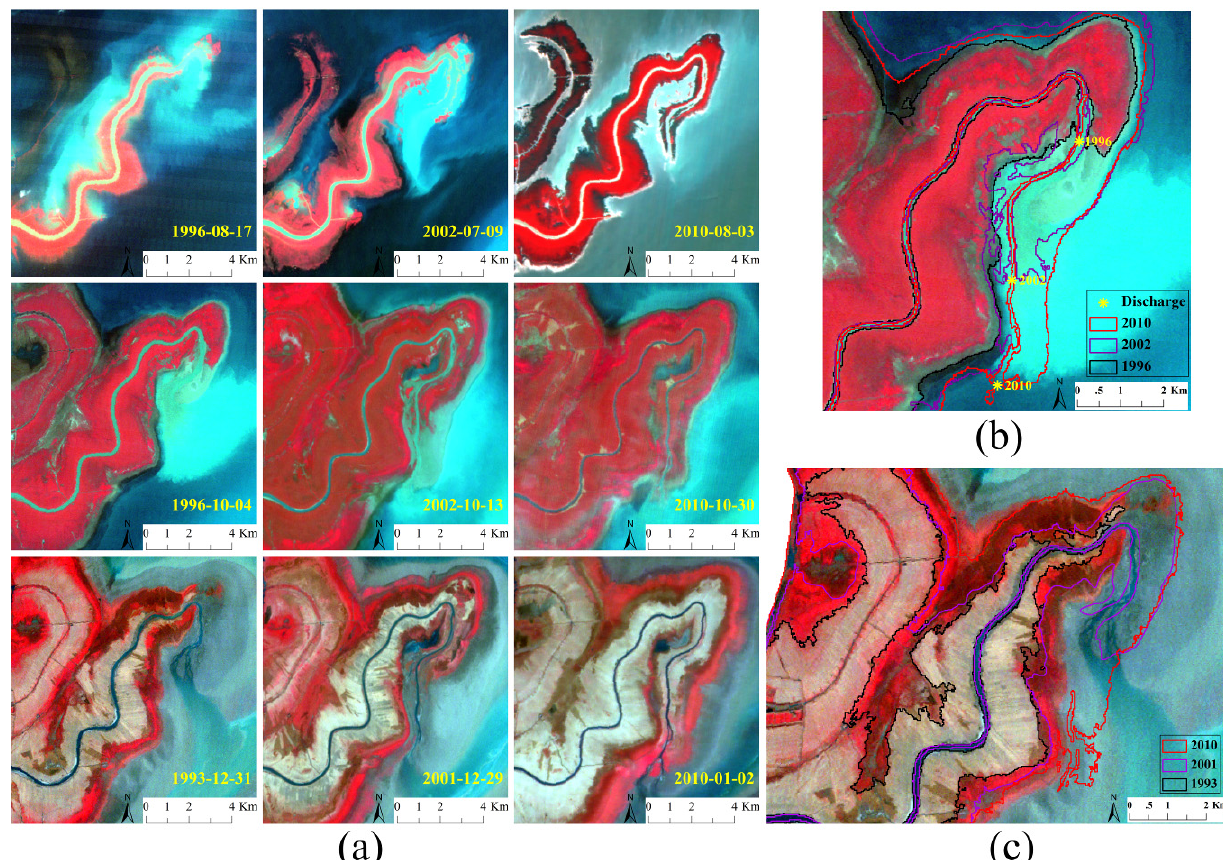
Figure 14. ( a ) Changes in spectral characteristics of remote sensing images in the region where the Ouchi River was flowing into the Dongting Lake in different seasons from 1993 to 2010. The underlying maps are Landsat false color composite images (4-3-2); ( b ) The evolution of boundaries between water and marshlands between 1996 and 2010 is presented. The base map is the Landsat image in 1996, and changes in locations of the yellow asterisk show the development of the injection point of the Ouchi River discharging into the Dongting Lake; ( c ) The evolution of reed wetlands during 1993 to 2010. The base map is the Landsat image in